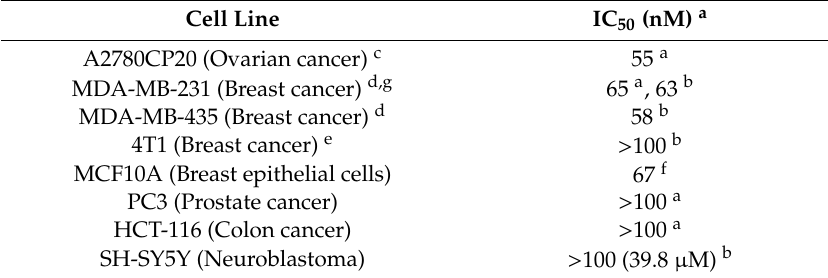
Table 5. Antiproliferative E ff ect of SKD on Cell Lines. Cell